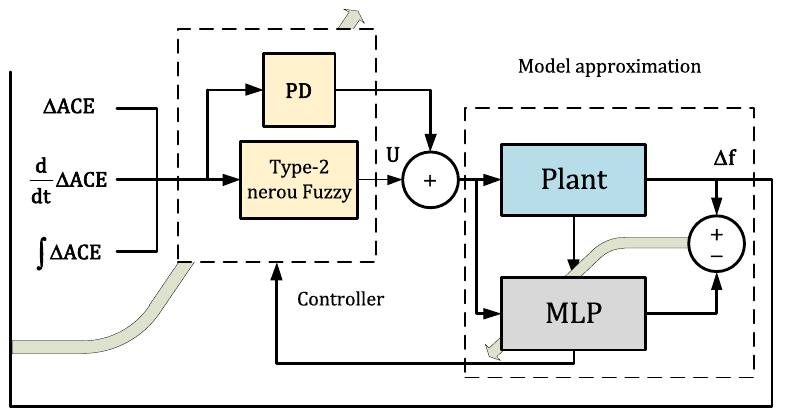
Figure 5. The proposed control structure.